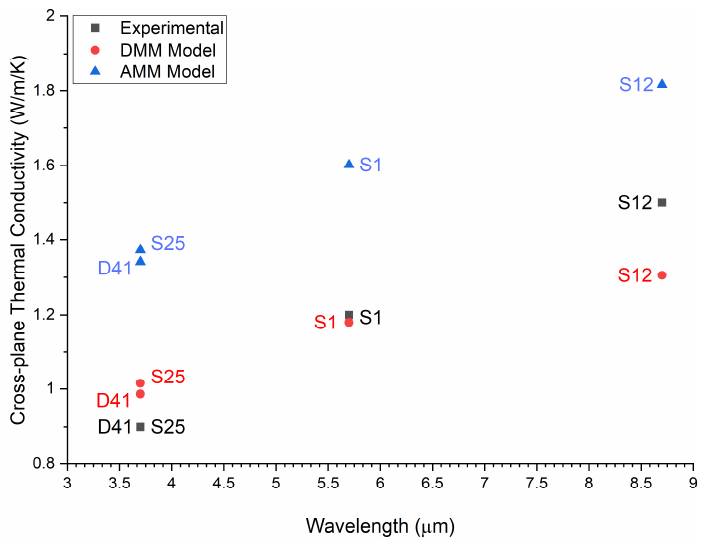
Figure 6. Cross-plane thermal conductivities vs wavelength for the four structures analyzed, both experimentally and through both phonon transport model calculations. experimentally and through both phonon transport model calculations.